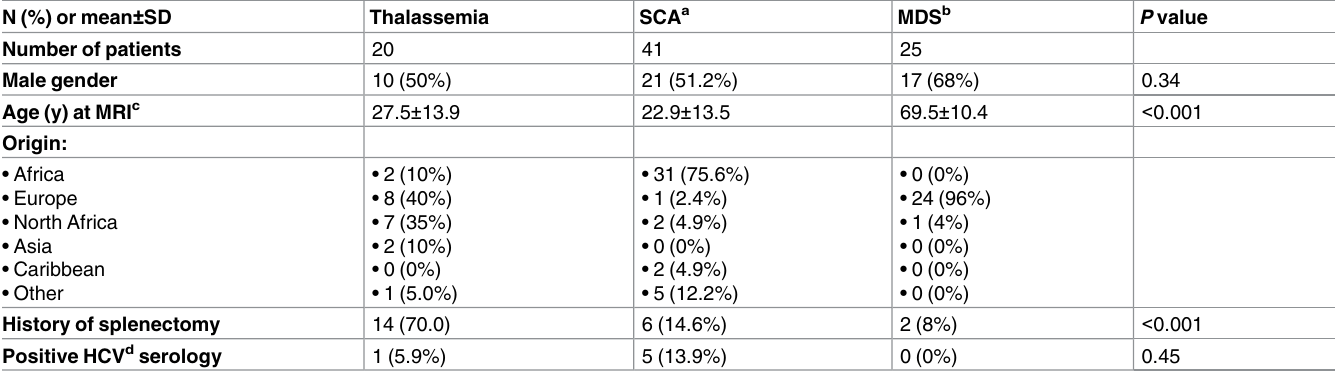
Table 1. Main patient